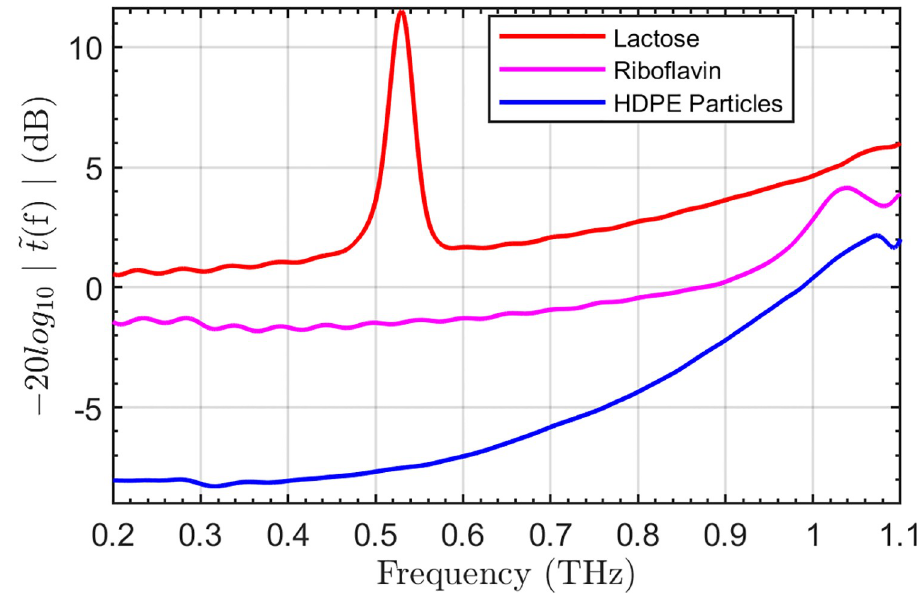
Fig 3. Transmission spectra. The power spectra of the 180 μ m HDPE particles (blue), lactose (red), and riboflavin (magenta) are shown, vertically offset for clarity.